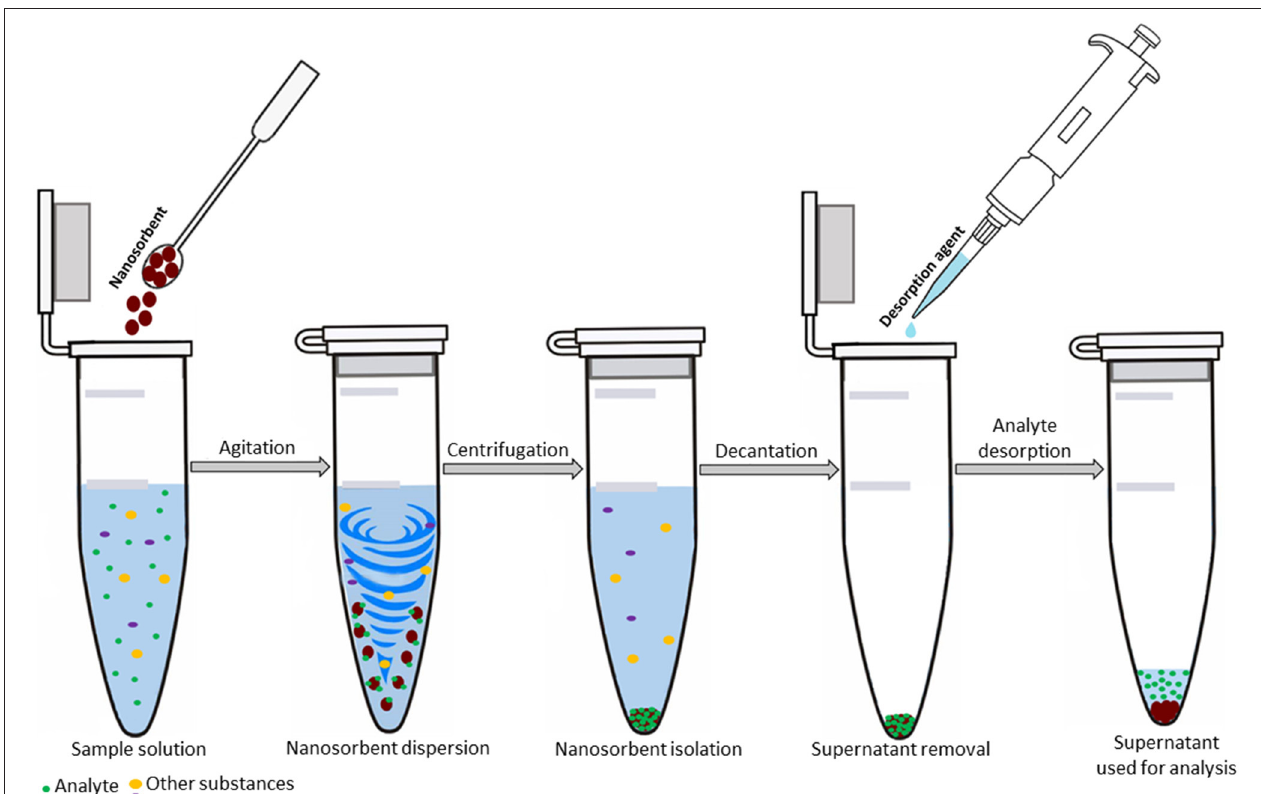
FIGURE 1 | Illustration of the main steps of DMSPE